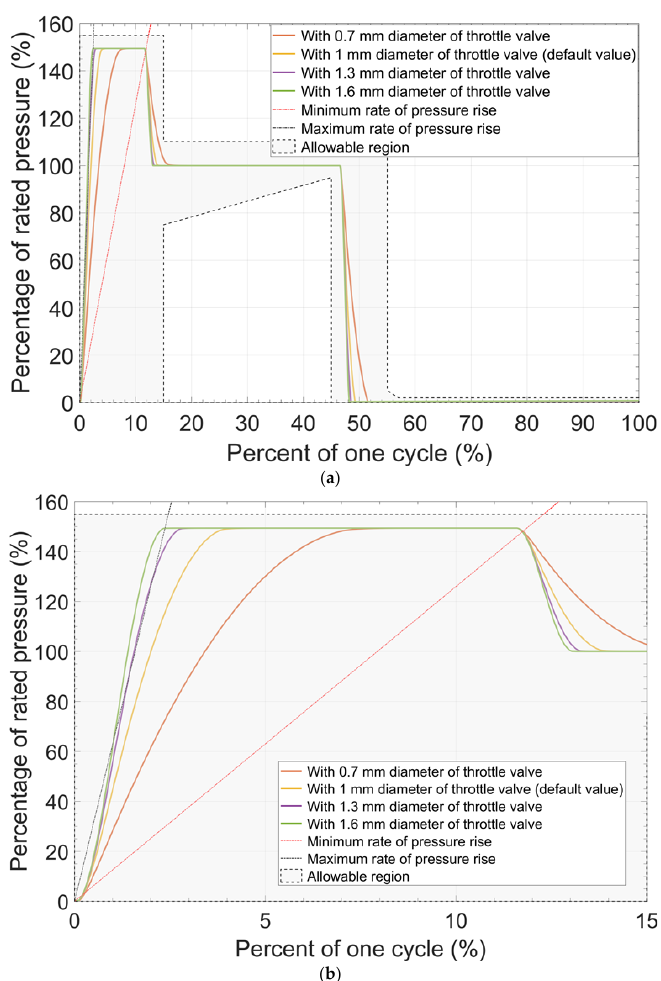
Figure 5. Effect of different diameters of the throttle valve. ( a ) The complete, dimensionless figure. ( b ) Magnified view of a part of the figure shown in ( a